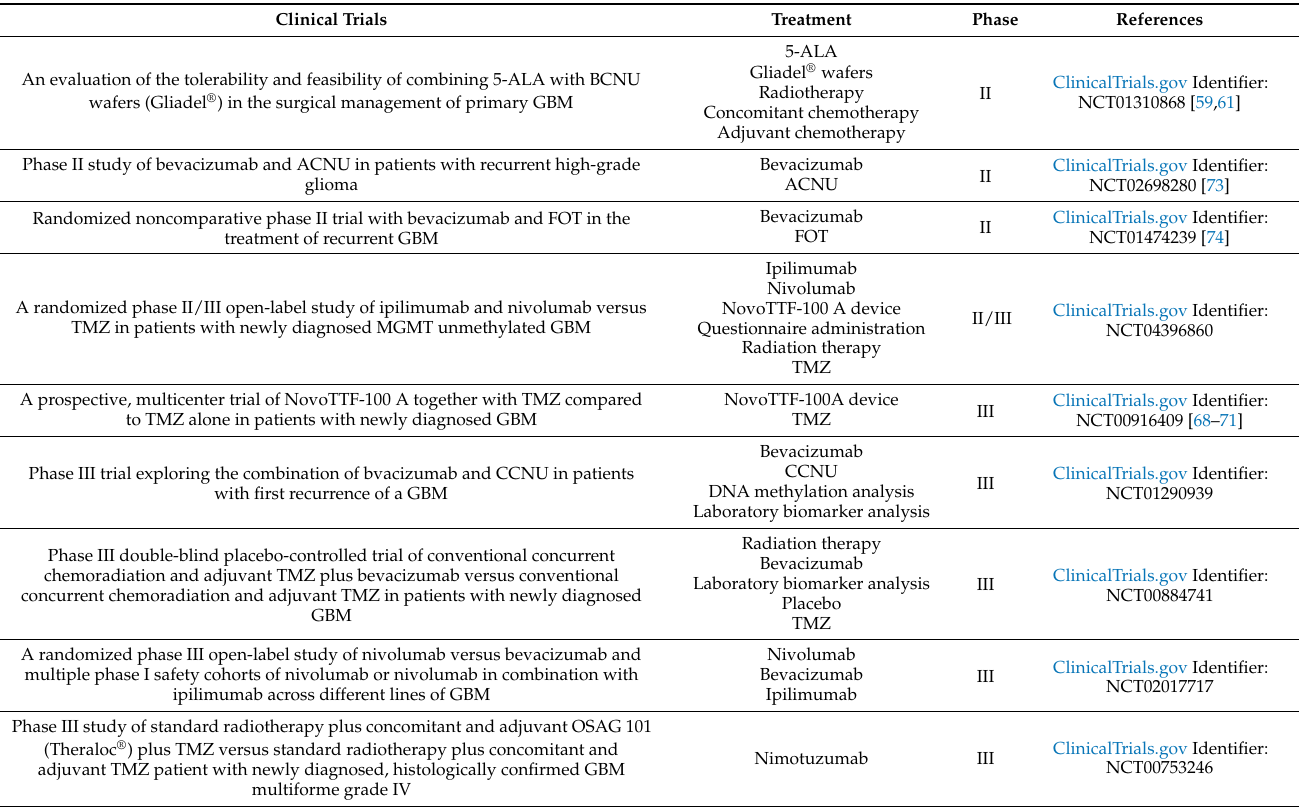
Table 3. Some clinical trials in the II/III phase designed for GBM